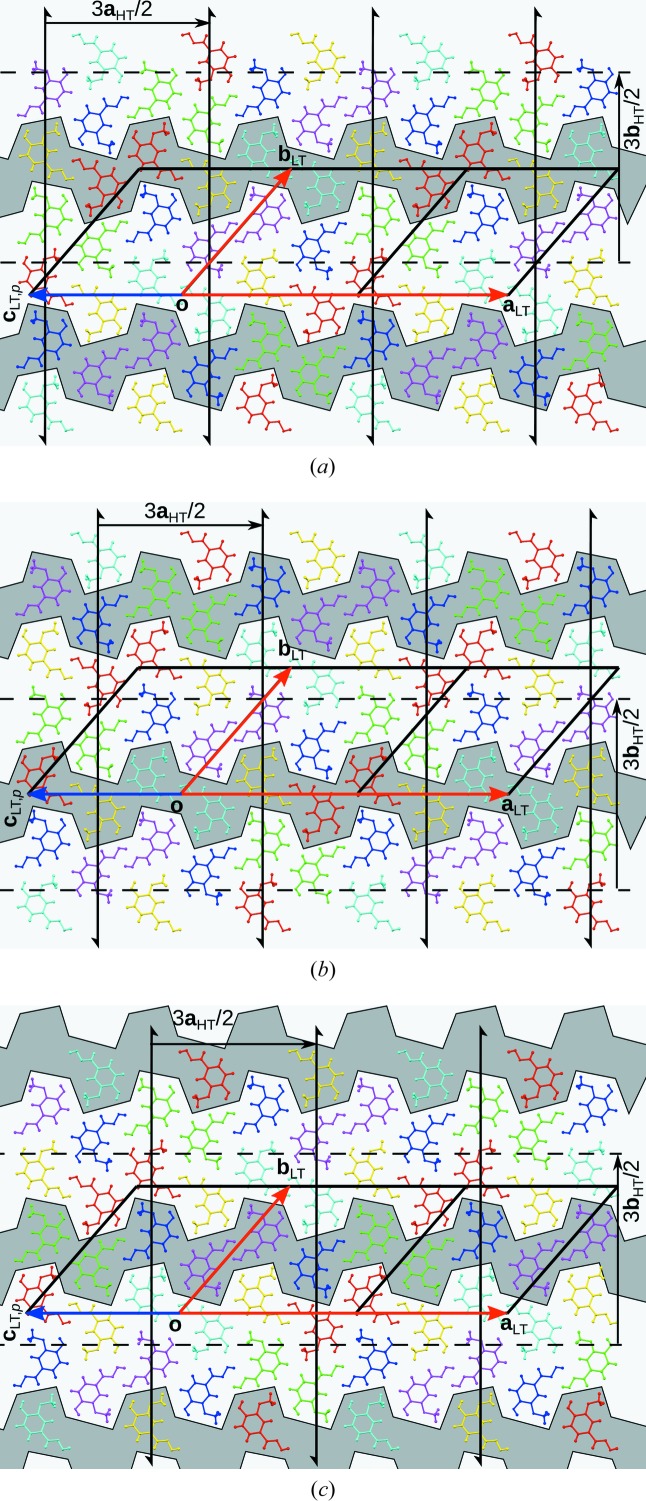
Source and target molecules of partial screw rotations and glide planes with intrinsic translation (6n + 3)b
LT/2 and (6n + 3)a
LT/2, respectively, in the LT phase. Molecule colours are as in Fig. 3 ▸.